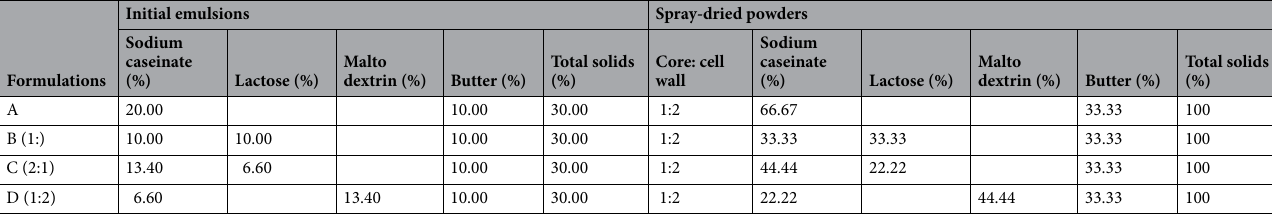
Table 1. Formulations of initial emulsions and spray-dried